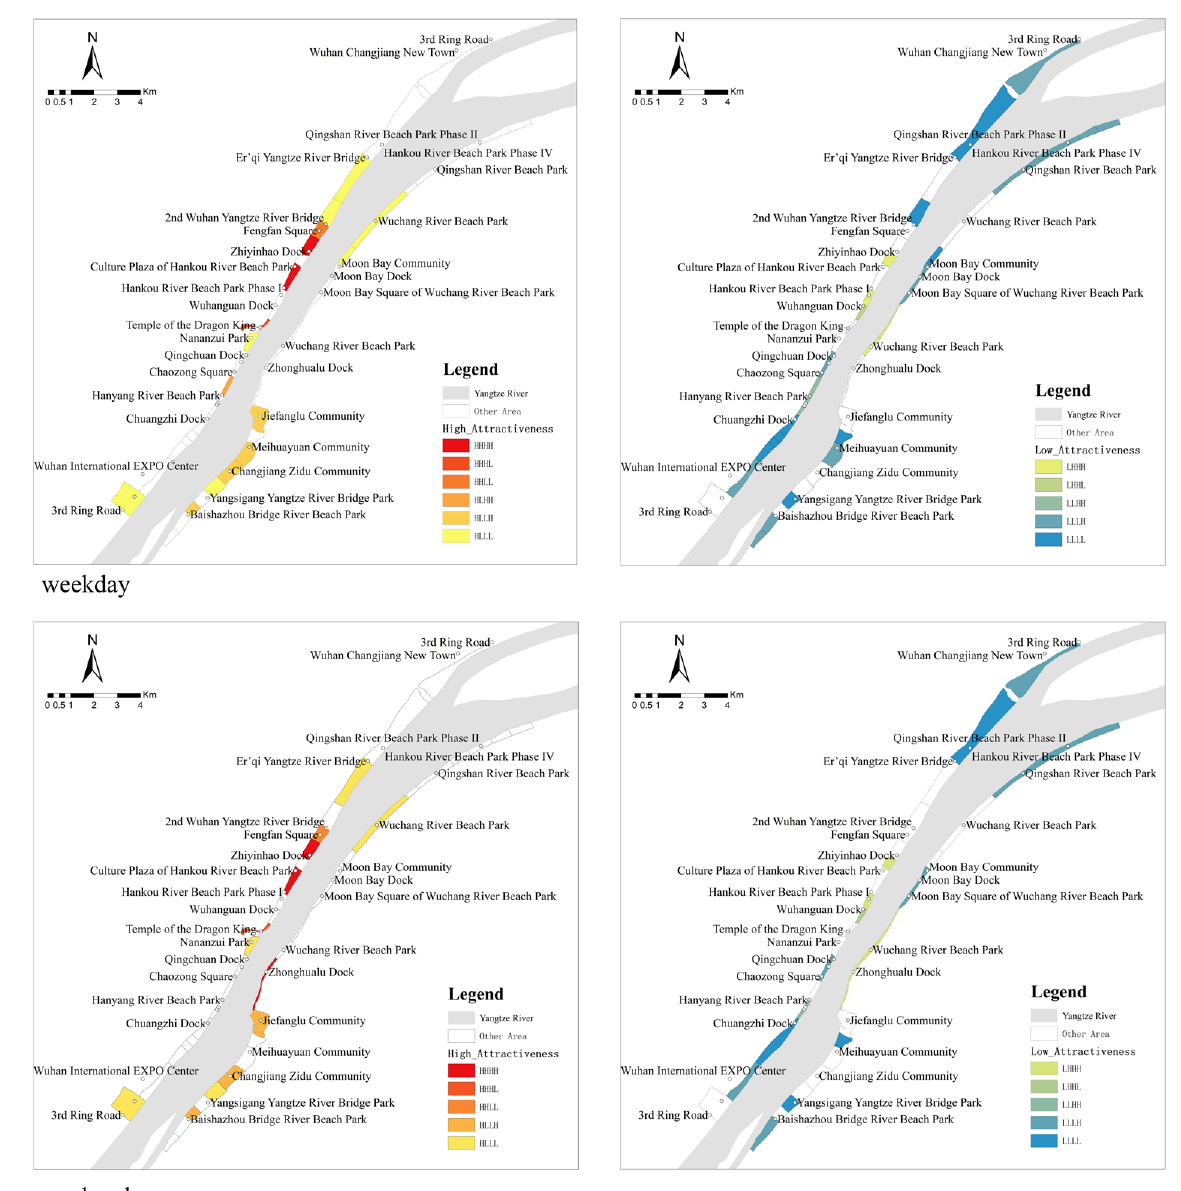
Figure 11. The type distribution of the riverside area of Wuhan.